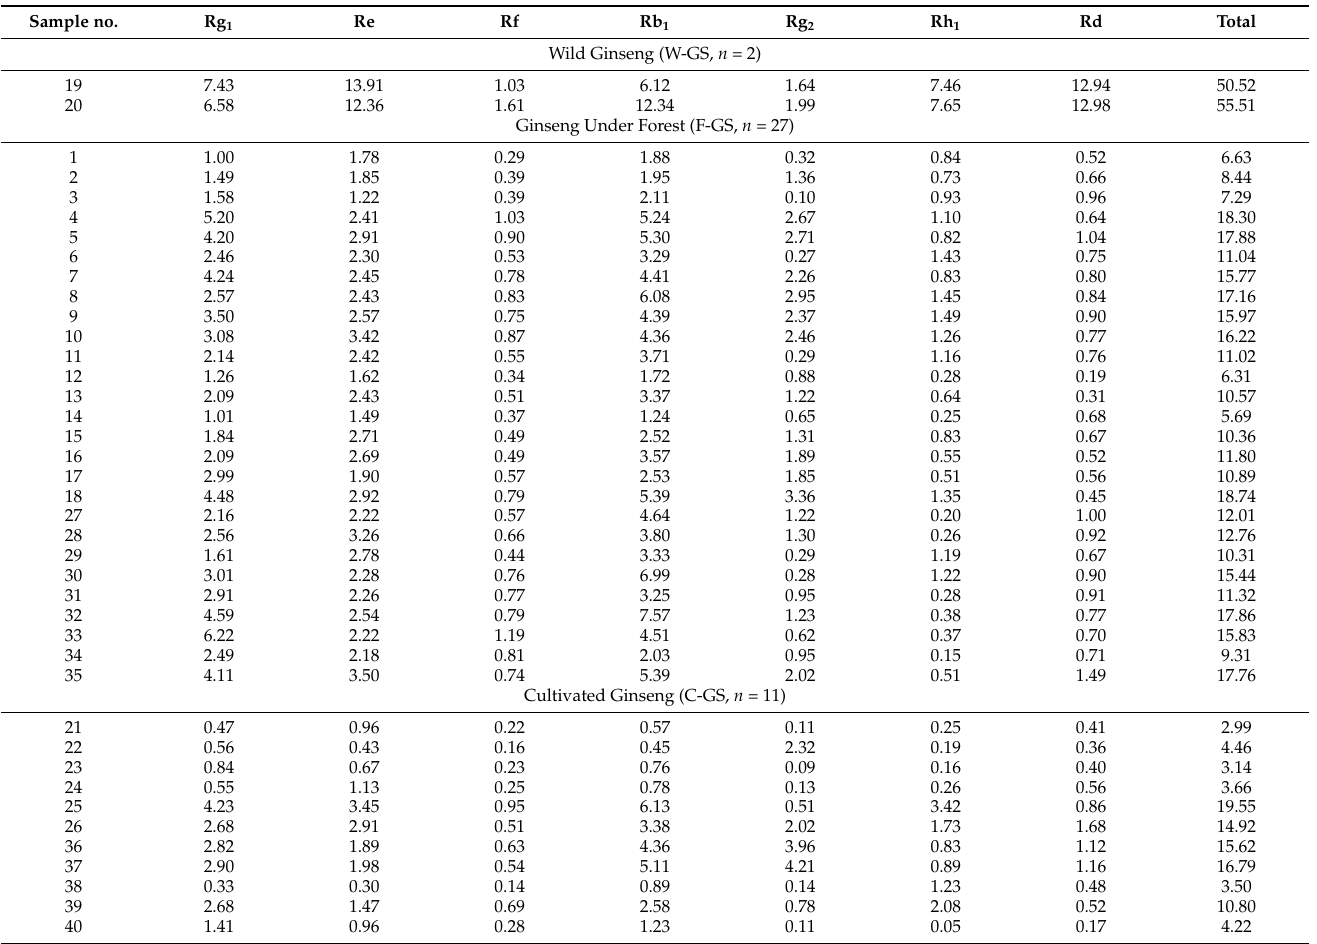
Table 3. Individual contents of seven ginsenosides in three types of ginseng samples assayed by “quantitative analysis of multi-component with single marker” (QAMS) method referring to ginsenoside Rg 1 (mg/g). Sample no.